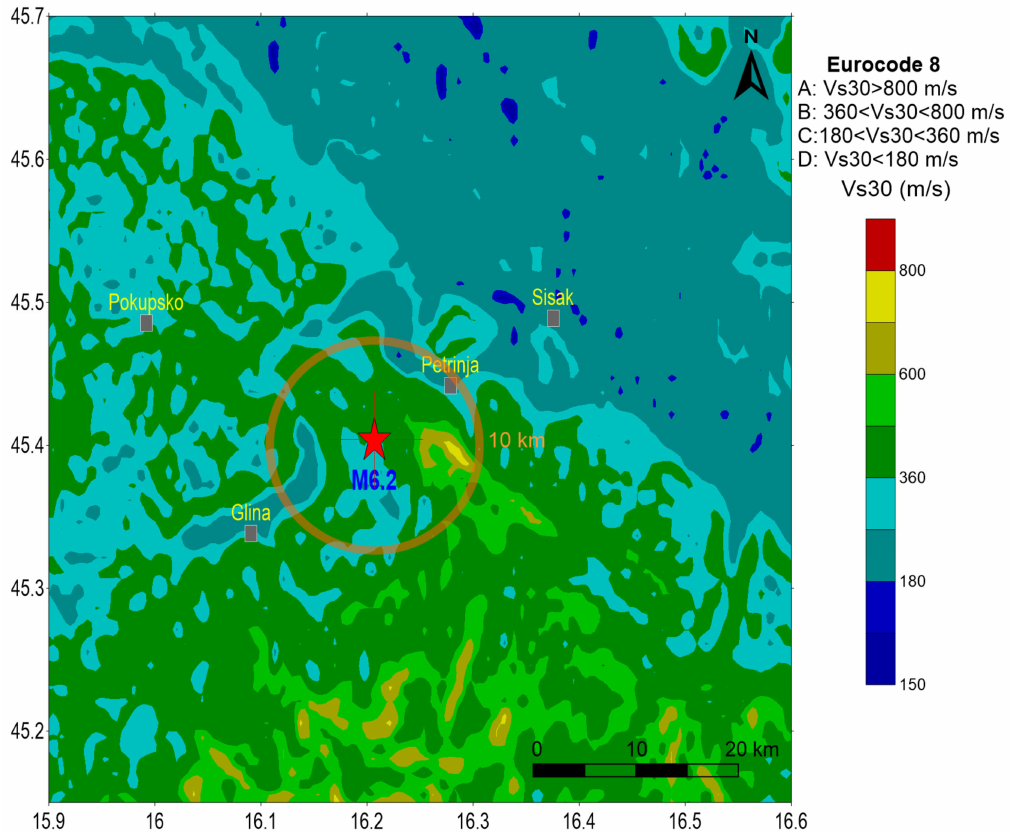
Figure 14. Available V S30 map that is based on topographic slope [69]. The red star represents the location of the M6.2 Petrinja 2020 earthquake ( M w 6.4 by USGS). The orange circle represents a 10 km distance from the